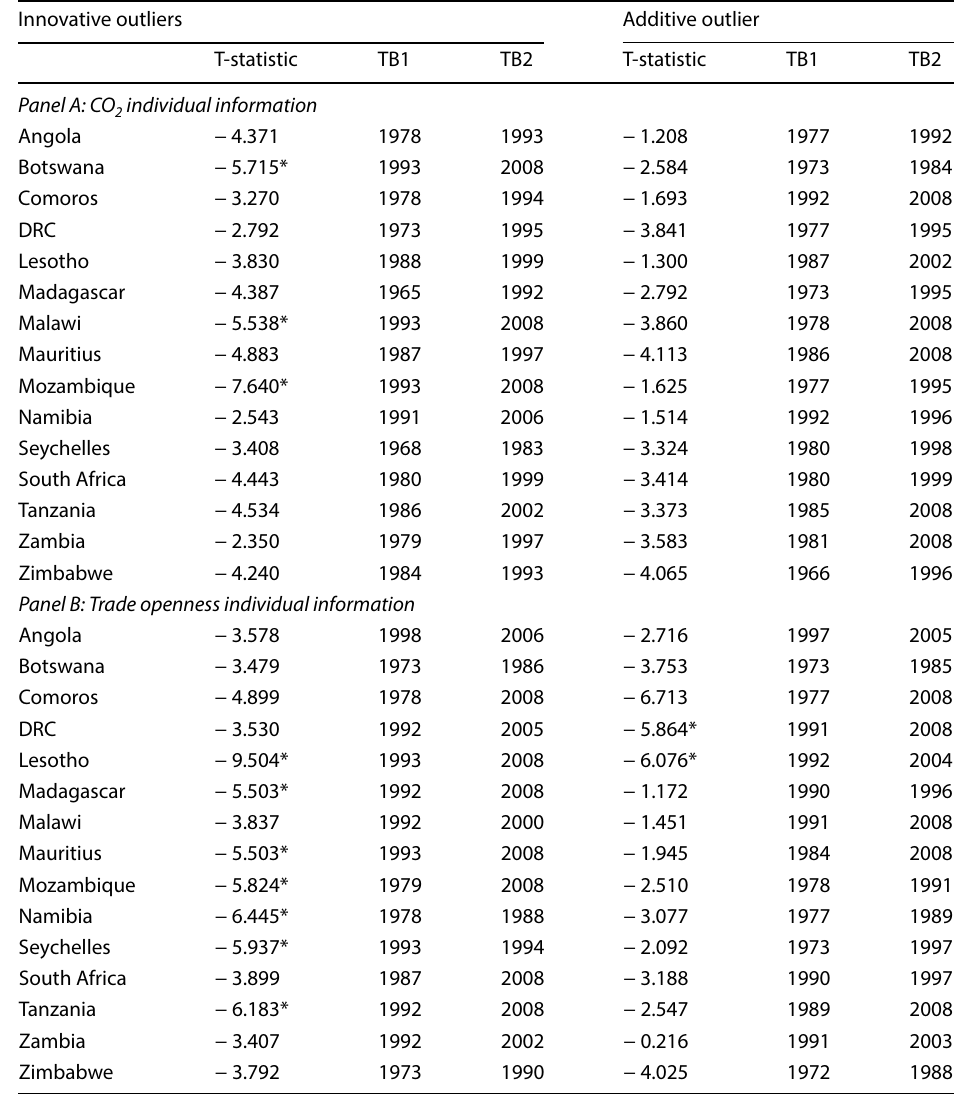
Table 18 Clemente- Montanes-Reyes detrended unit root